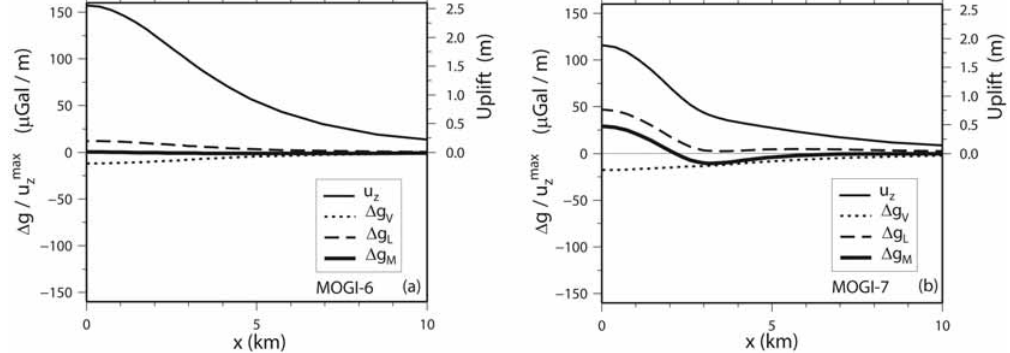
Fig. 10a,b. Gravity terms normalized to the maximum uplift u z max , and vertical displacement in an inelastic medium: a) all plastic, b) plastic caldera and remaining elastic.